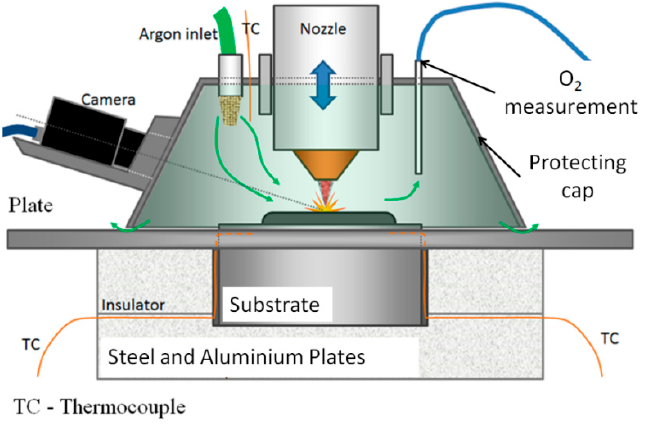
Figure 1. Scheme of laser metal powder directed-energy deposition (LMPDED) equipment used for manufacturing thin-wall specimens.